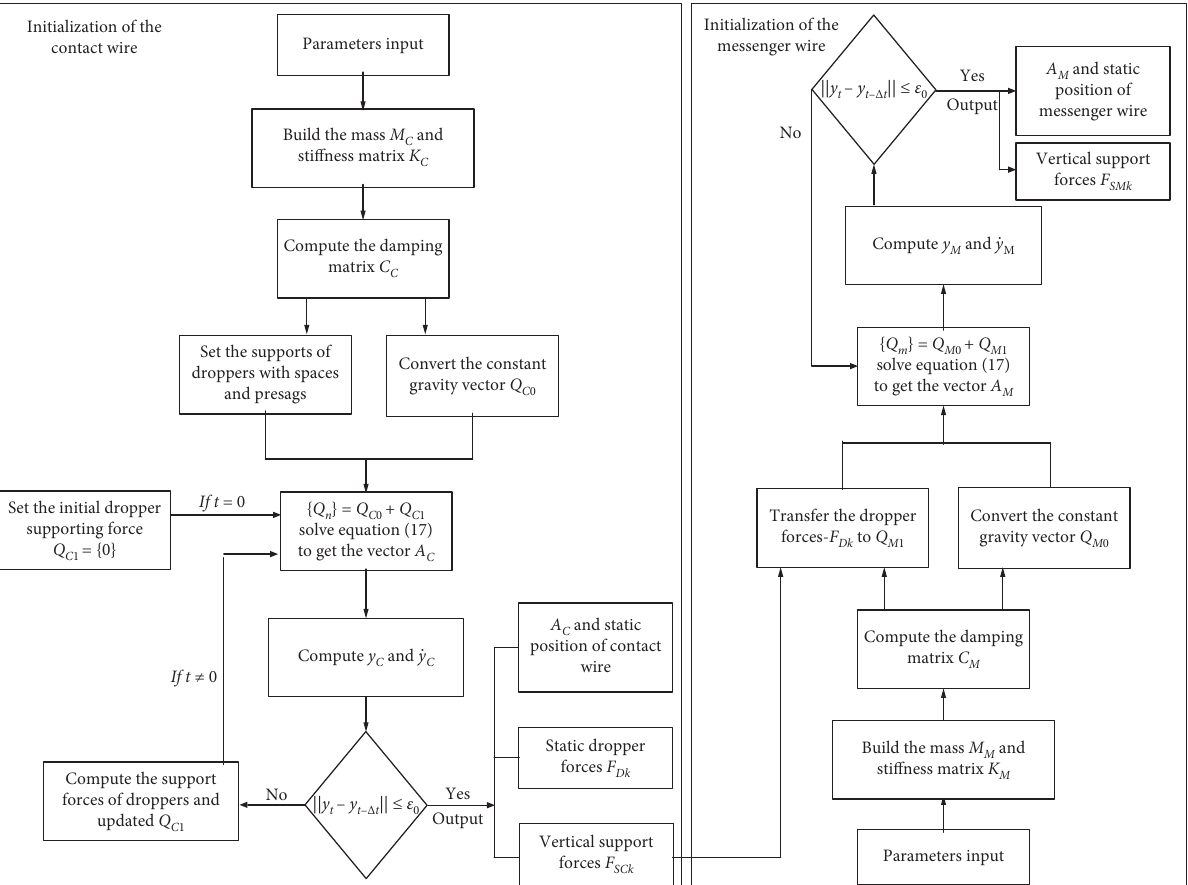
Figure 9: Initialization of the catenary.